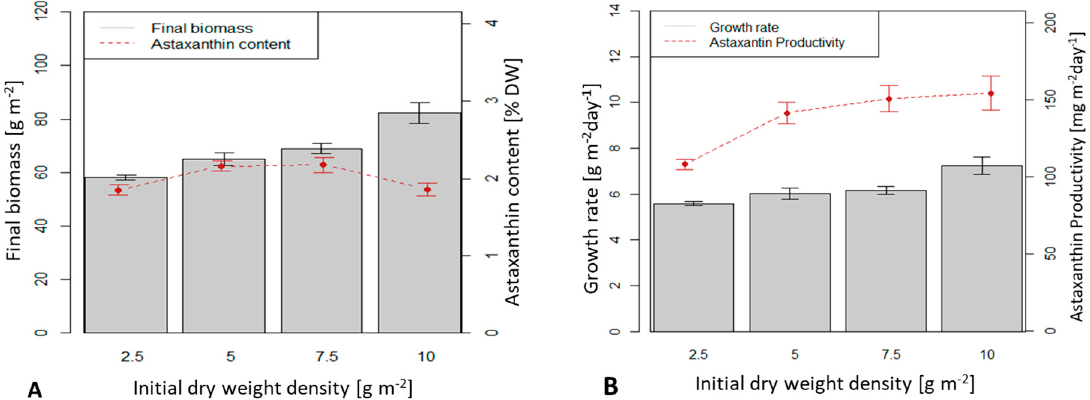
Figure 5. Final biomass and astaxanthin content in dry weight (%) in H. pluvialis at different initial biomass densities after 10 days of growth in a TL-BSBR. ( A ) Final biomass and astaxanthin content; ( B ) Biomass growth rate (average of biomass increase in 10 days) and astaxanthin productivity.